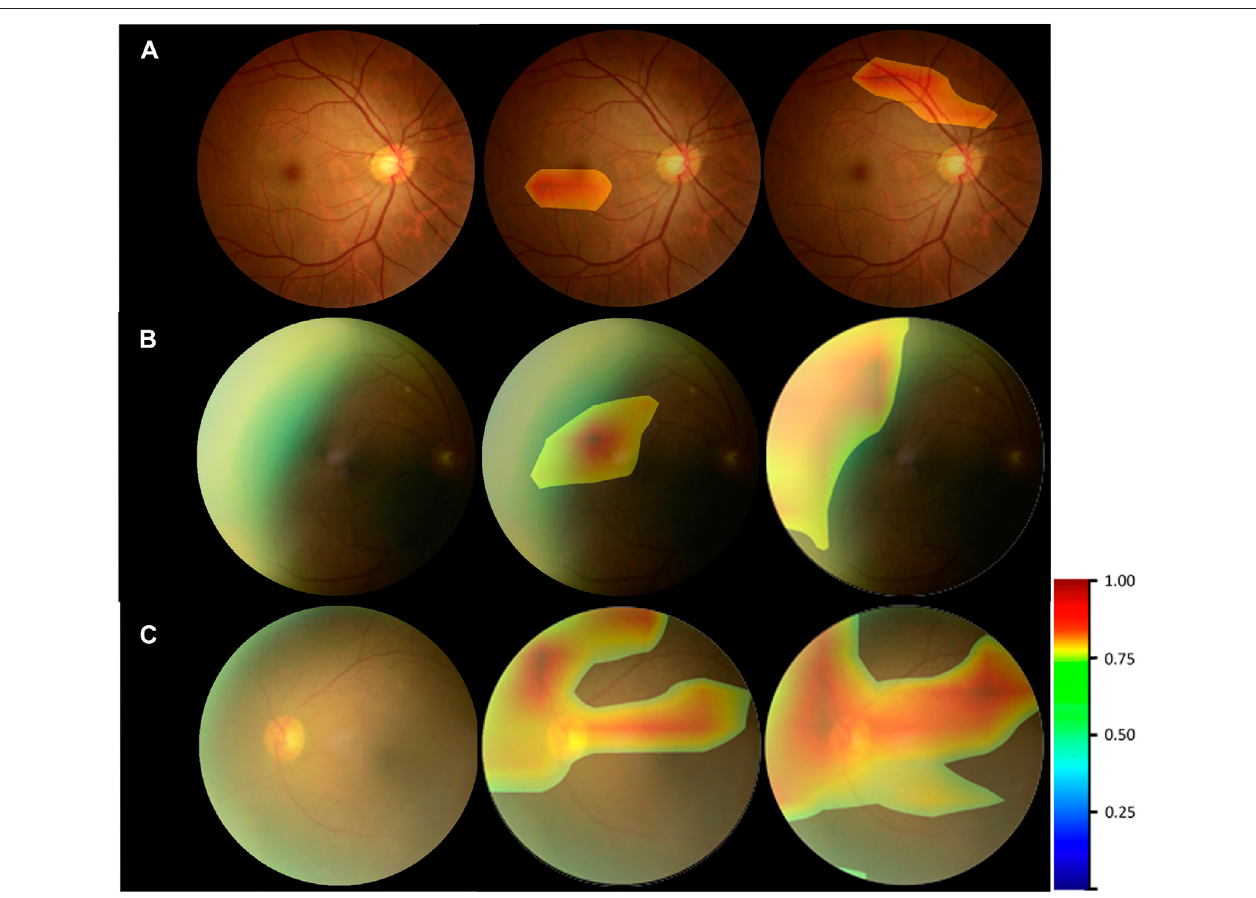
FIGURE 6 | Heatmap visualization examples. Left column: the original fundus images; middle column: general heatmap of antiinterference method; right column: general heatmap of control experiment. (A) noncataract with normal-quality image. (B) noncataract with poor-quality image. (C) cataract.